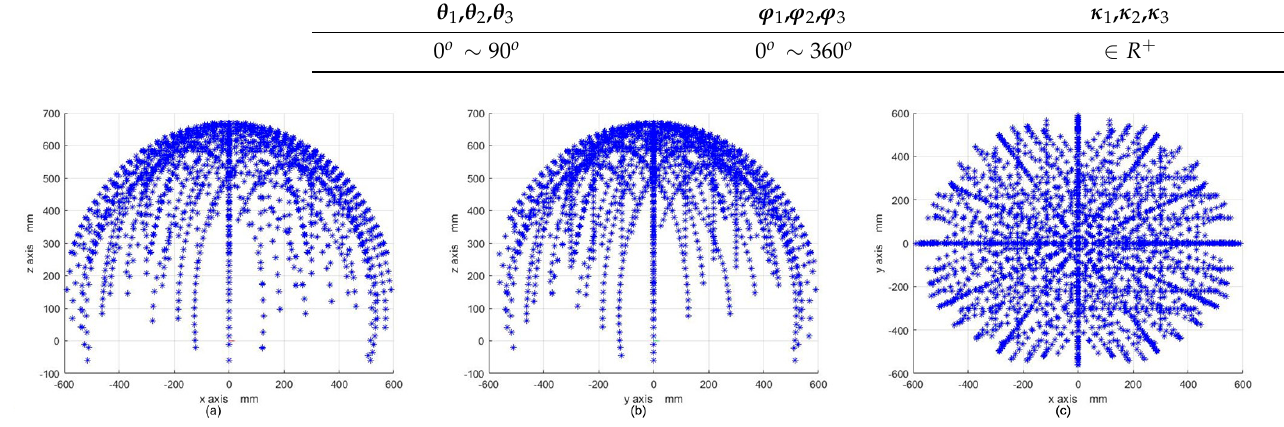
Figure 9. Working space analysis of the proposed continuum robot: ( a ) x -axis, ( b ) y -axis, ( c ) z -axis.